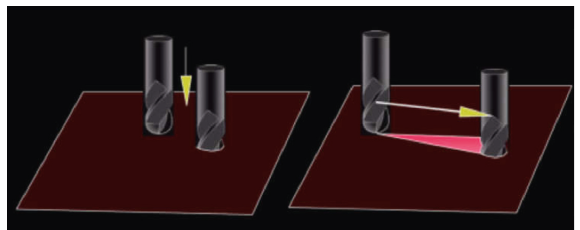
Figure 3: Schematic diagram of reducing the number of tool